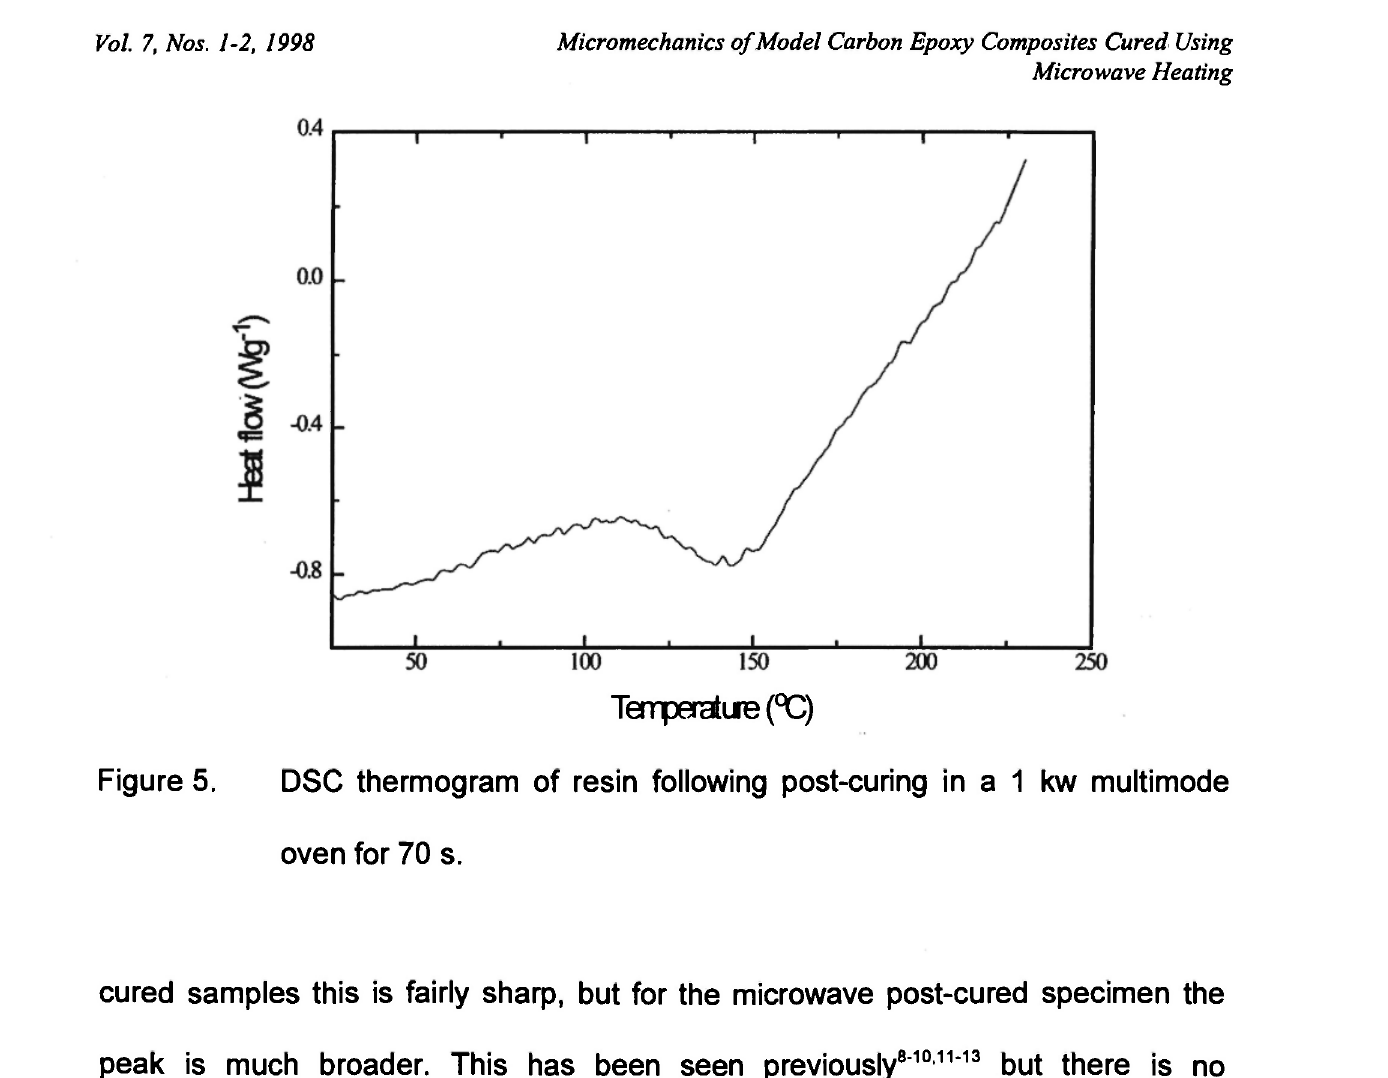
Figure 5. DSC thermogram of resin following post-curing in a 1 kw multimode oven for 70